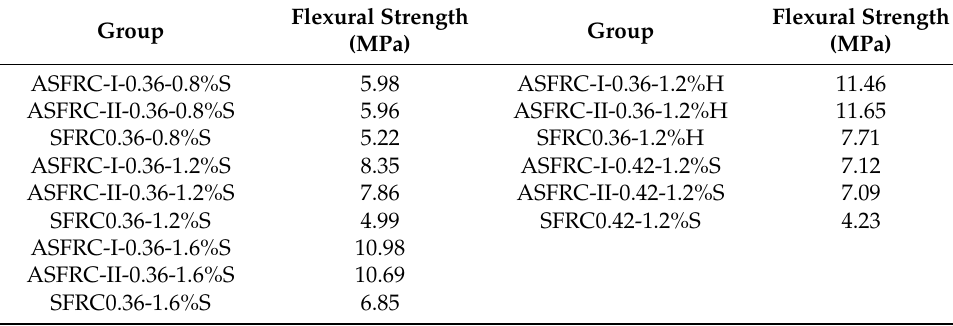
Table 4. Flexural strength of ASFRC-I, ASFRC-II, and the SFRC.